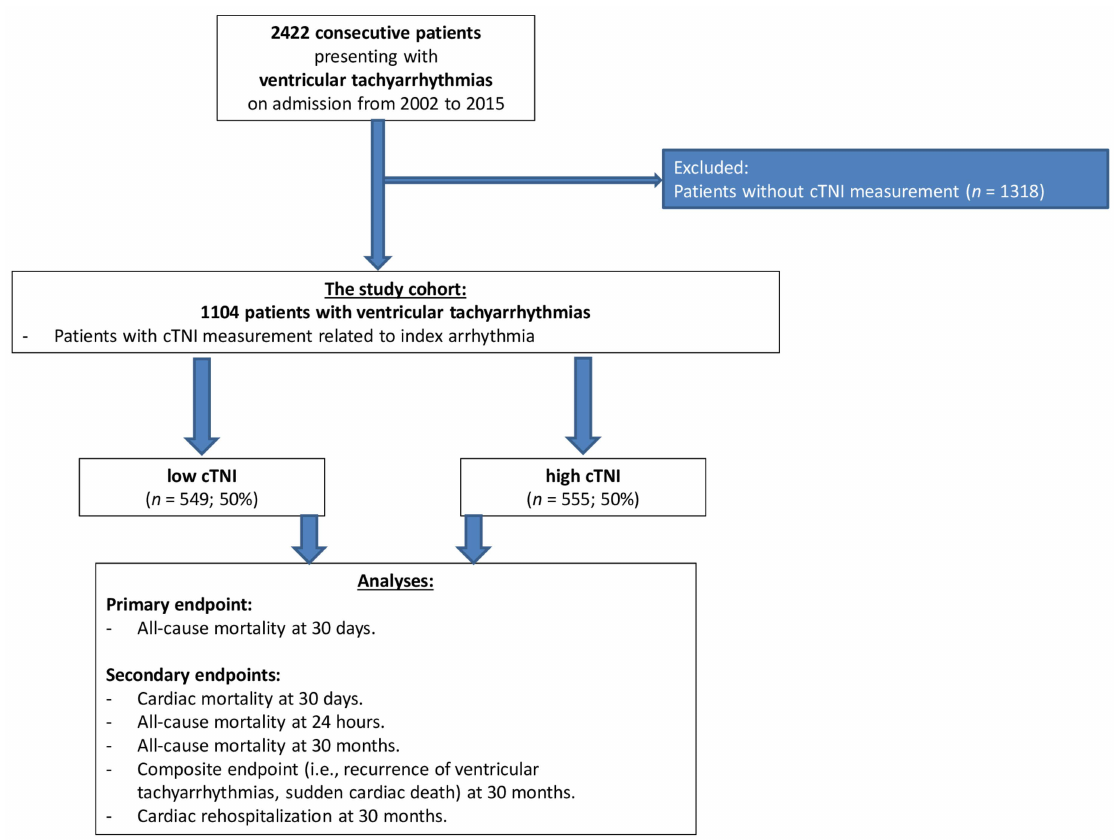
Figure 1. Study population. cTNI, cardiac troponin I.